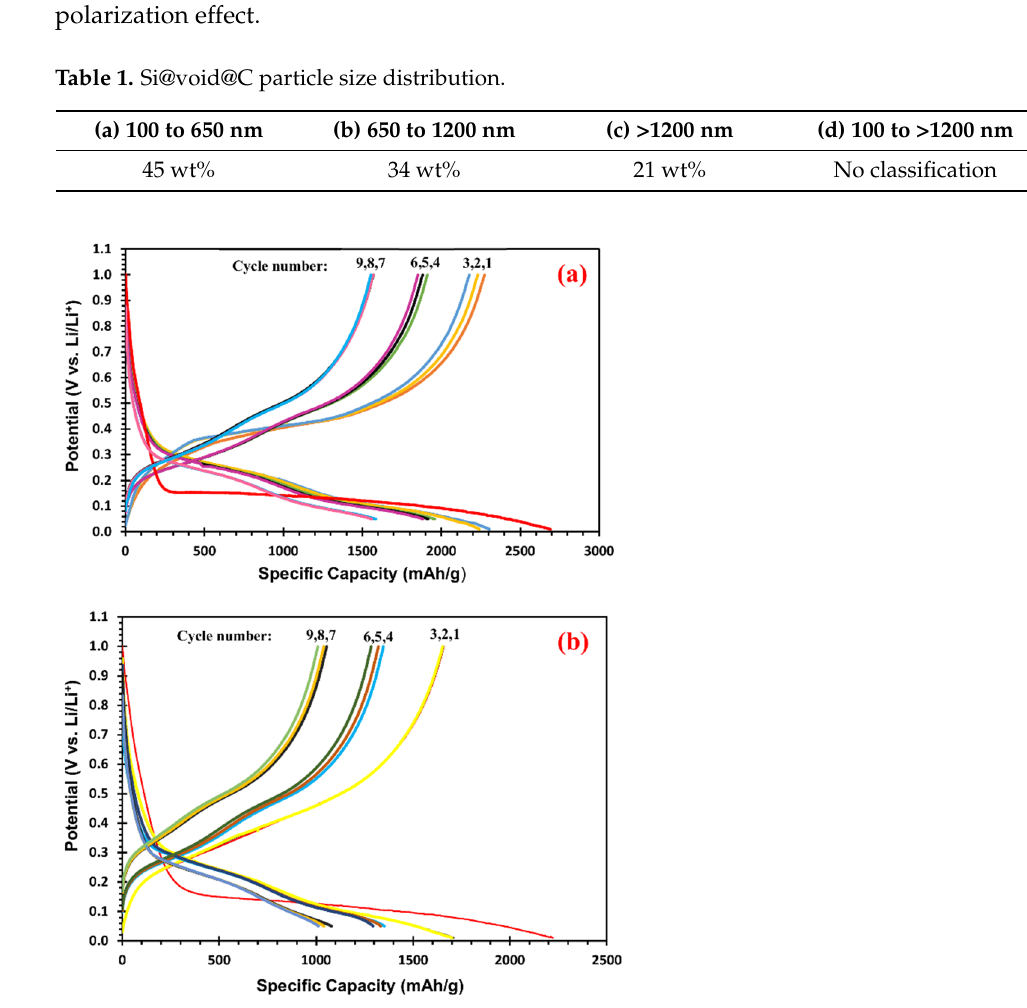
Figure 2. The voltage vs. specific capacity curves of Si@void@C half cells: ( a ) the smallest size group